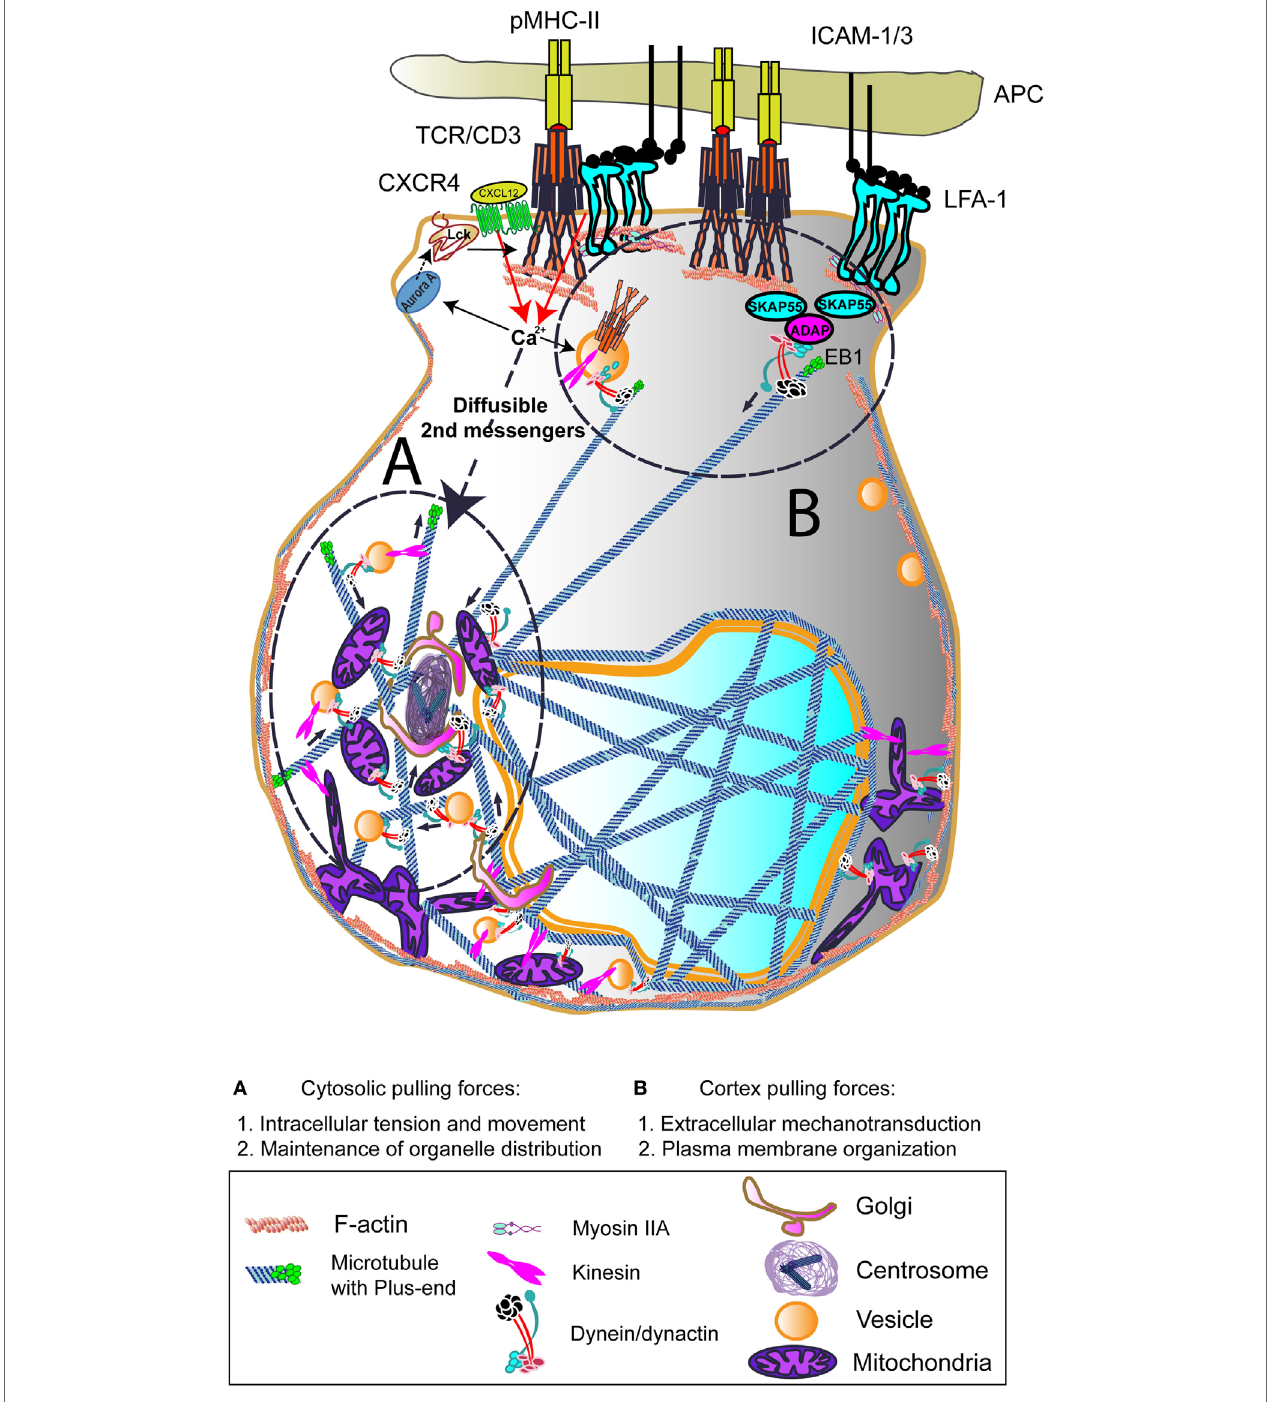
FigURe 1 | Dynein-driven forces acting on centrosome polarization during early T cell activation. Centrosome polarization upon T cell receptor (TCR) activation can be mediated by cortex and/or cytosolic pulling forces. TCR, lymphoctye function-associated antigen-1 (LFA-1), and CXCR4 binding to its ligands involve rapid increases in Ca 2 + intracellular influx. This can activate Aurora A, which will favor leukocyte C-terminal Src kinase (Lck) activation and subsequent CD3 ITAMs phosphorylation at the CD3/TCR complex. The activation of the centrosome and associated molecules is probably due to diffusible secondary messengers such as the Ca 2 + . The interaction of dynein/dynactin complexes and other motors with intracellular organelles and the cytoskeleton may induce the force needed to move the centrosome toward the immune synapse (IS). At the IS, the interaction with TCR/CD3/SKAP55/ADAP or LFA-1/SKAP55/ADAP may serve to dock growing microtubules (MTs) and to pull the centrosome to the IS. End-binding 1 (EB1) may interact directly to CD3 ζ subunit of the CD3/TCR complex. The growth and shrinkage of MTs at this zone would also create pulling forces. The images in the figure are not scaled.